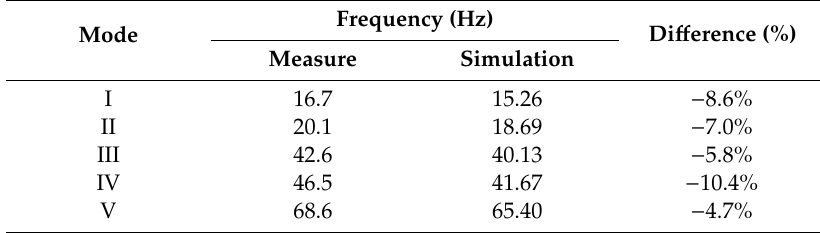
Table 10. Comparing the results from modal analysis in terms of natural frequencies.